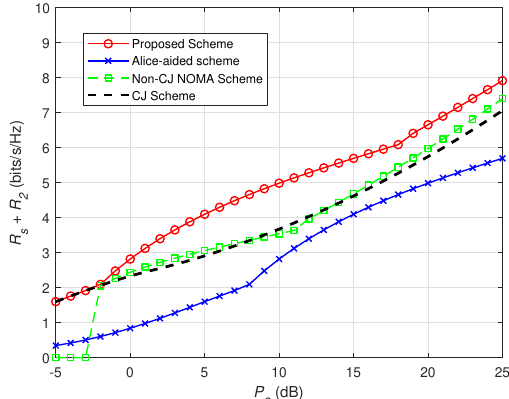
Figure 4. Effective sum rate vs. the transmit power of Alice P a